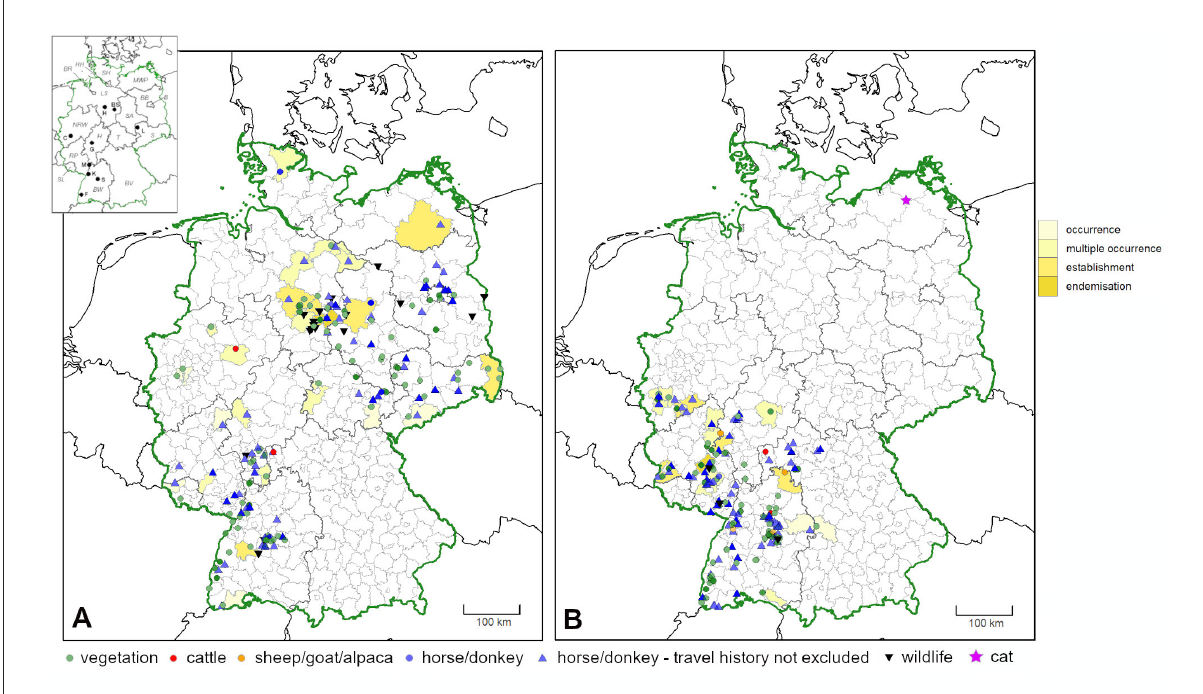
FIGURE3 Confirmed occurrence of (A) D. reticulatus and (B) D. marginatus in Germany, based on ticks found on the vegetation and infestations on-site or in the closer vicinity, i.e., ticks found on pastured animals and terrestrial wildlife. Additionally, horses/donkeys for which a travel history cannot be entirely excluded were pictured. Maps include data of the present study, from Drehmann et al. (10) and locations where ticks were flagged from the vegetation by the involved research institutions. More intense colors indicate multiple findings in close proximity. Administrative districts with previously unreported confirmed Dermacentor occurrence as compared to Rubel et al. (47) are shaded in yellow. In addition, the finding of D. marginatus in Mecklenburg-Western Pomerania on a cat without travel history is pictured by a star. In the map insert, federal states are abbreviated with italic letters (B, Berlin; BR, Bremen; BW, Baden-Wuerttemberg; BV, Bavaria; BB, Brandenburg; HH, Free and Hanseatic city of Hamburg; H, Hesse; LS, Lower Saxony; MWP, Mecklenburg-Western Pomerania; NRW, North Rhine-Westphalia; RP, Rhineland-Palatinate; S, Saxony; SA, Saxony-Anhalt; SH, Schleswig-Holstein; SL, Saarland; T, Thuringia) and cities with bold letters (BS, Brunswick; C, Cologne; F, Freiburg; G, Gießen; H, Hanover; K, Karlsruhe; L, Leipzig; M, Mannheim; S,